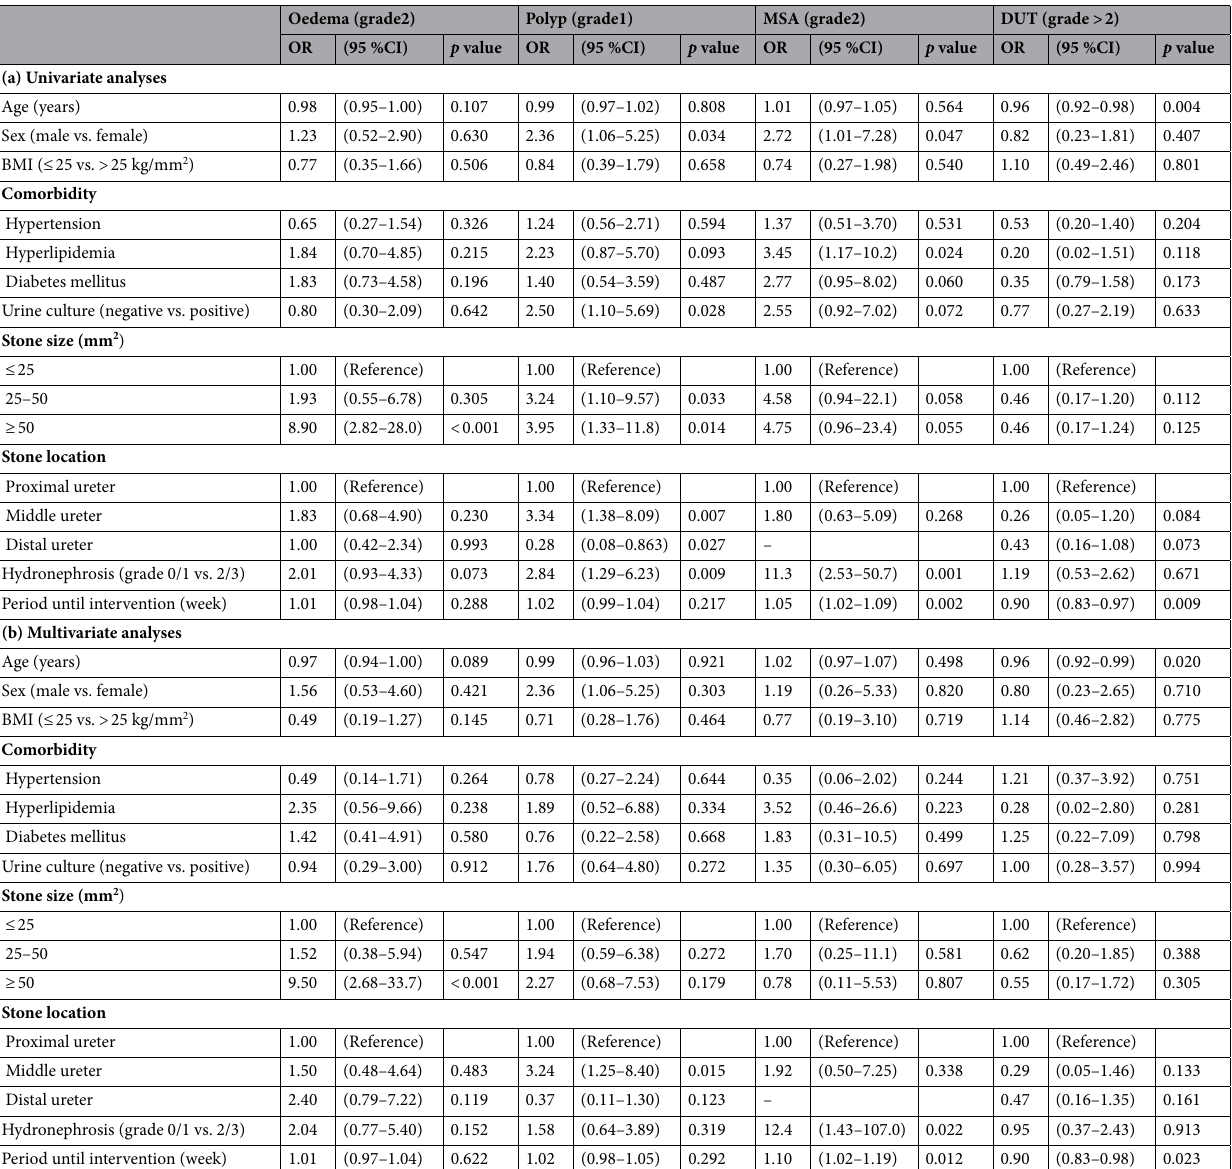
Table 6. Parameters associated with severe endoscopic